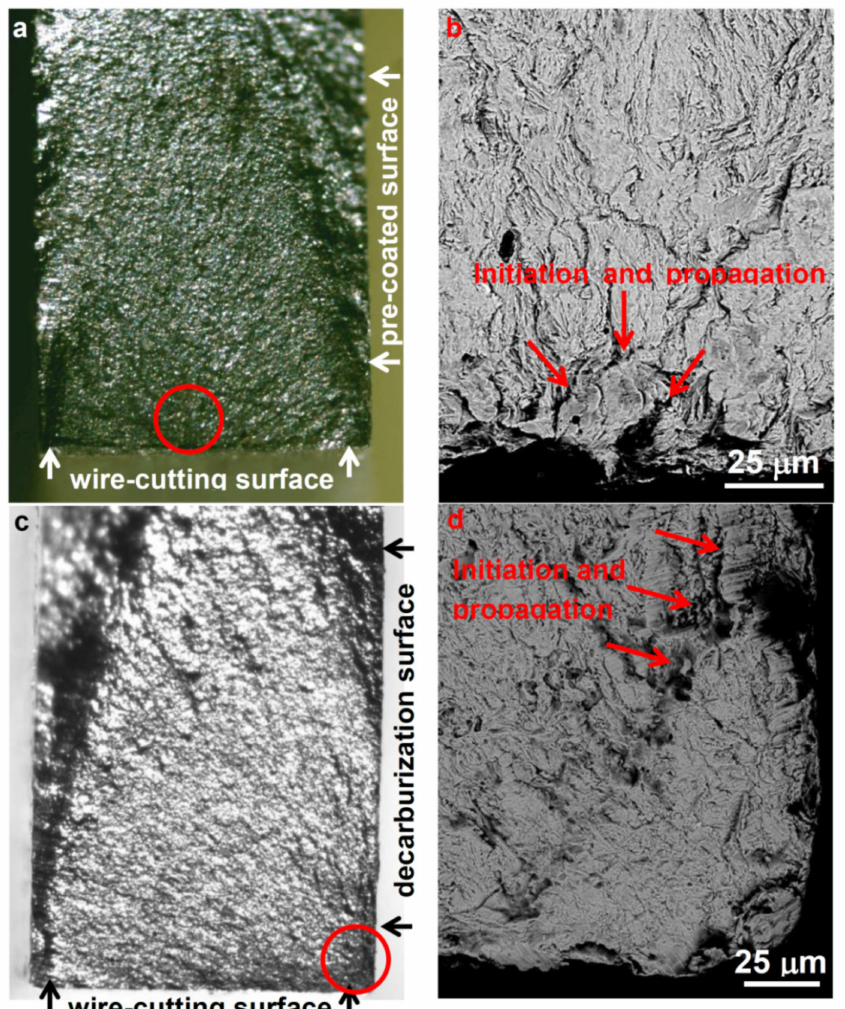
Figure 7. Fracture macrographs of coated ( a ) and uncoated ( c ) specimens under 390 MPa after hot stamping at 1193 K. ( b , d ) are the enlarged images showing the crack initiation and early propagation (marked by